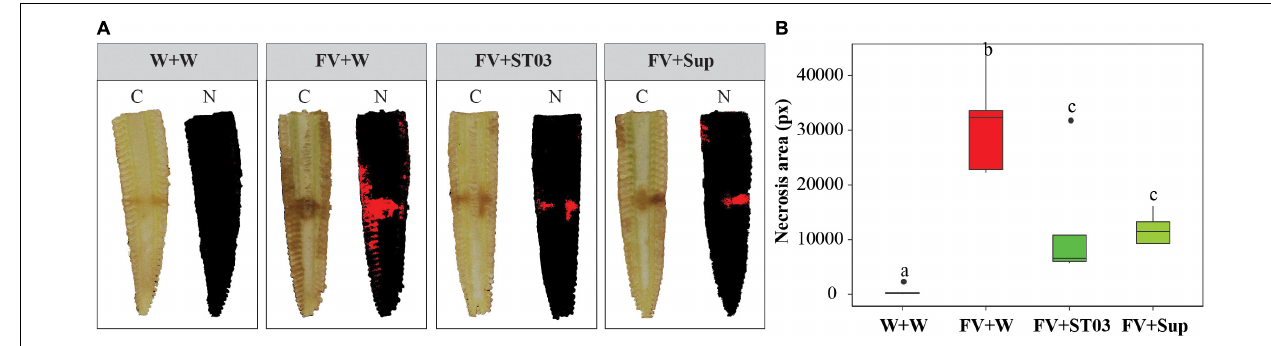
FIGURE 3 | Impact of the Streptomyces strain ST03 when co-applied with Fusarium verticillioides on maize cobs. (A) Imaging inside maize cobs by treatments at 7 days using a multispectral camera. Color images (C) , and necrosis images in red color (N). (B) Necrosis area (px) by treatments. Negative maize cob control was inoculated with sterile water (W + W), positive maize cob control comprised F. verticillioides and sterile water (FV + W), two biocontrol treatments included F. verticillioides and the Streptomyces cell suspension (FV + ST03)/or the supernatant of the strain ST03 (FV + Sup). Different letters above each box depict the significant difference between treatments using a Kruskal–Wallis test followed by a post hoc Dunn’s test at a significant level of α = 0.05. Five biological replicates were performed per treatment. The experiment was repeated